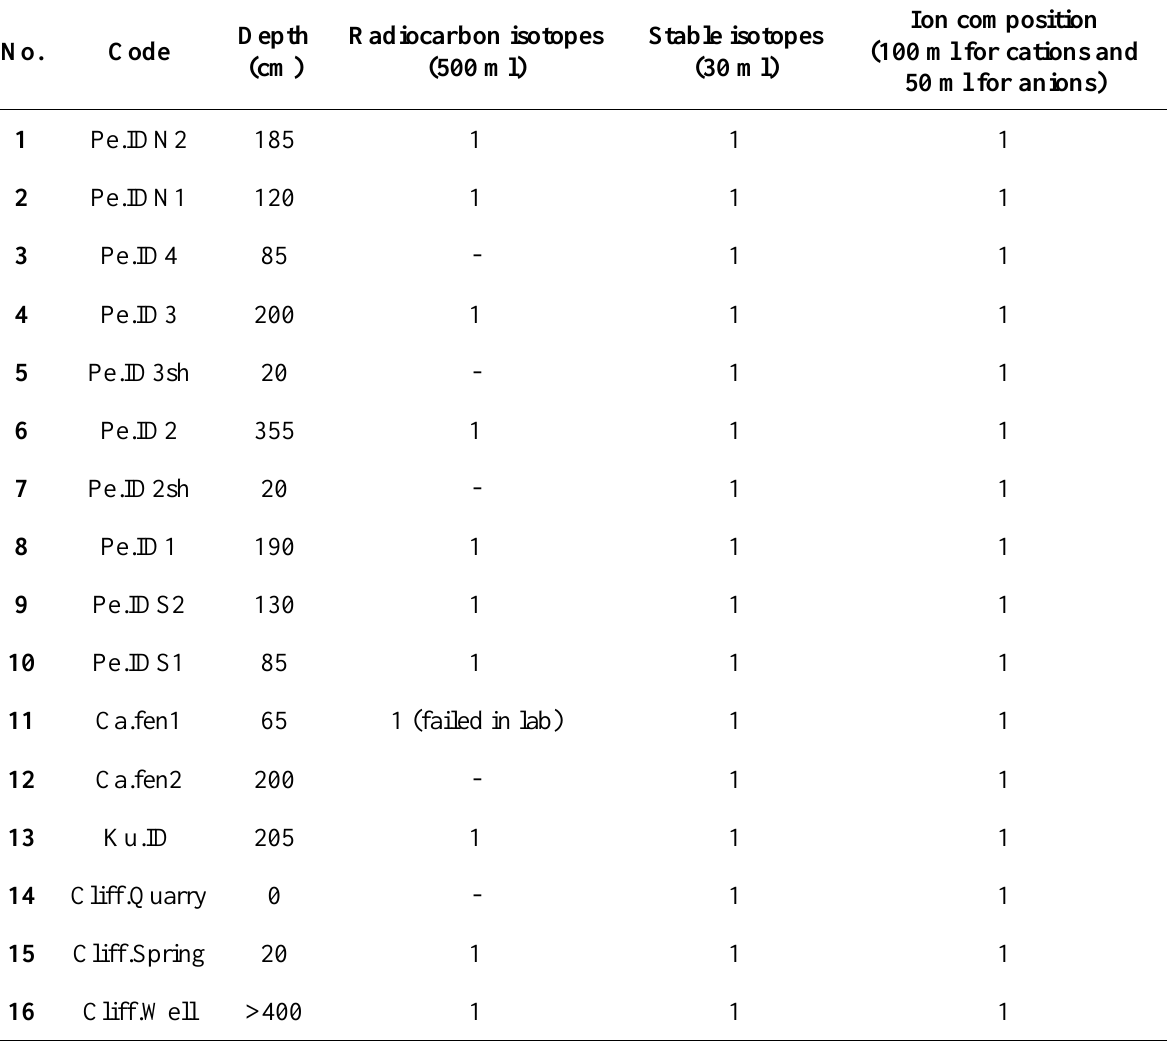
Table A1. List of the groundwater sampling locations, screen depths, analysed aspects of groundwater composition, and volumes used for each